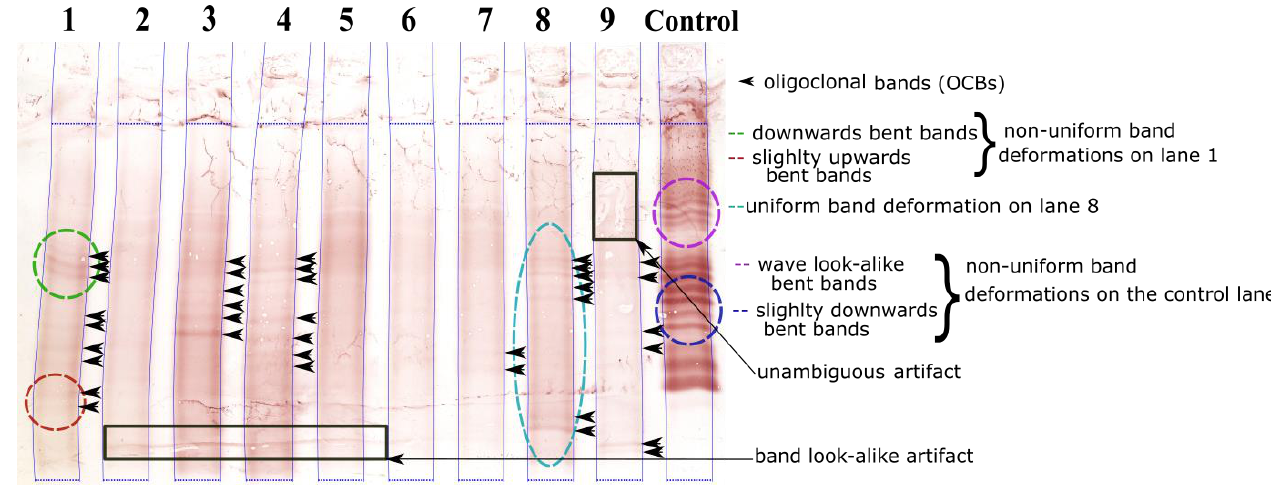
Figure 1. Example of a CSF IEF membrane with different types of band deformation: the left and right contours of each lane are delineated (blue lines) using our automatic lane segmentation method described in [11].